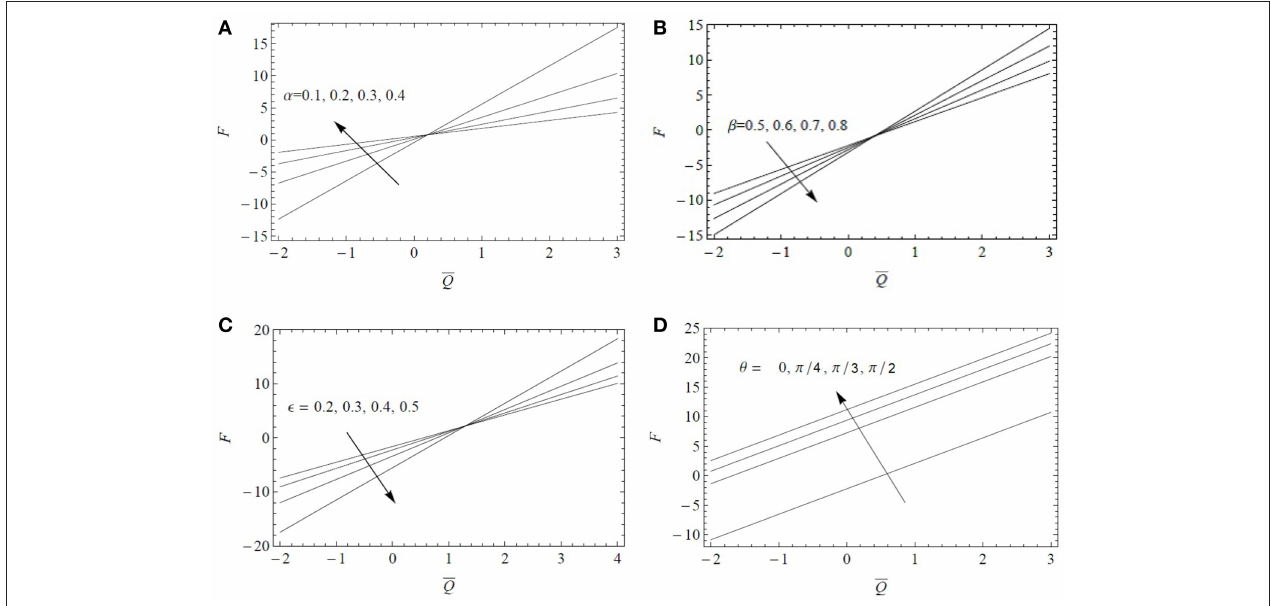
FIGURE 4 | Variations of F as a function of the flow rate ¯ Q for Fr = 0.1 and Re = 0.1: (A) influence of the fractional parameter α for α * = β * = 0.4, ǫ = 0.3, β = 0.6, λ 1 = 5, λ 2 = 1, λ 3 = 1, θ = π 3 ; (B) influence of the fractional parameter β for α * = β * = 0.4, ǫ = 0.3, α = 0.6, λ 1 = 5, λ 2 = 1, λ 3 = 1, θ = π 3 ; (C) influence of the cilia length ǫ = 0.2 for α = β = 0.6, α * = β * = 0.6, λ 1 = 5, λ 2 = 1, λ 3 = 1, θ = π 3 ; (D) influence of the inclination angle θ for ǫ = 0.3, α = β = 0.6, α * = β * = 0.6, λ 1 = 5, λ 2 = 1, λ 3 =